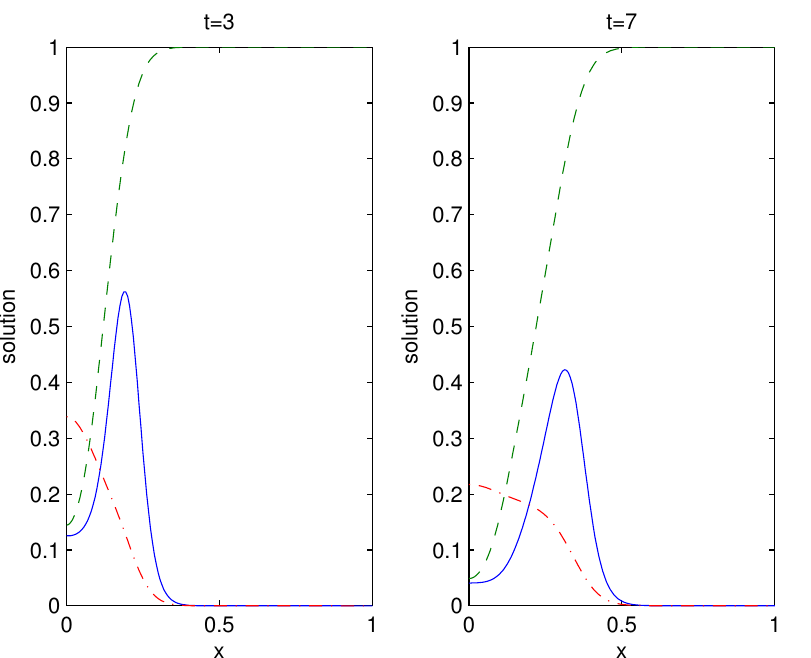
Figure 3. The solid line represents the density of cancer cells, the dashed line denotes the density of ECM, and the dasheed and dotted line denotes the concentration of MDE at time t = 3 and t = 7. Solutions with the parameter value d n = 0.001, Example